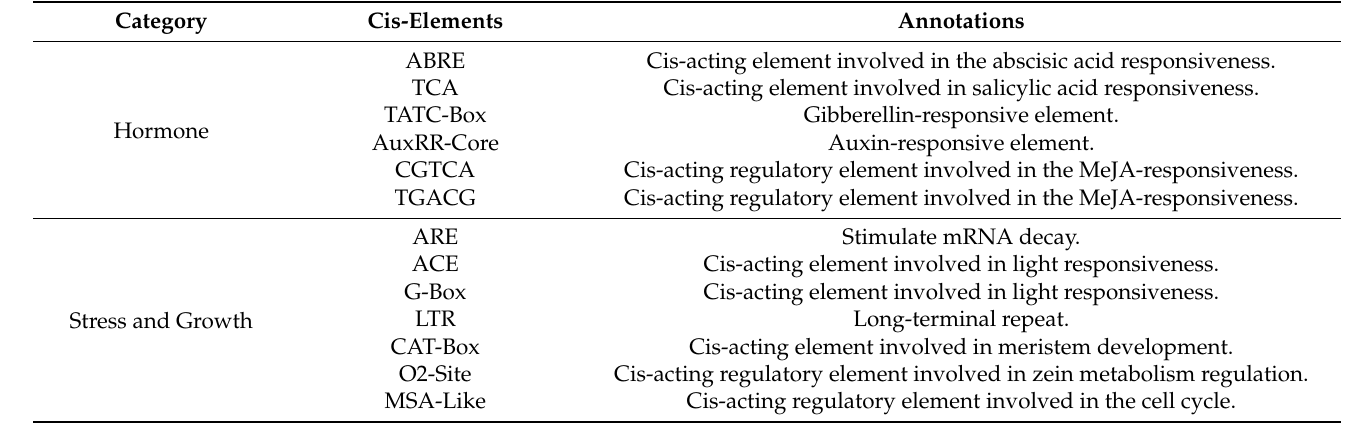
Table 3. Analysis of the diverse types and numbers of cis-acting regulatory elements involved in growth, development, stress, and hormonal